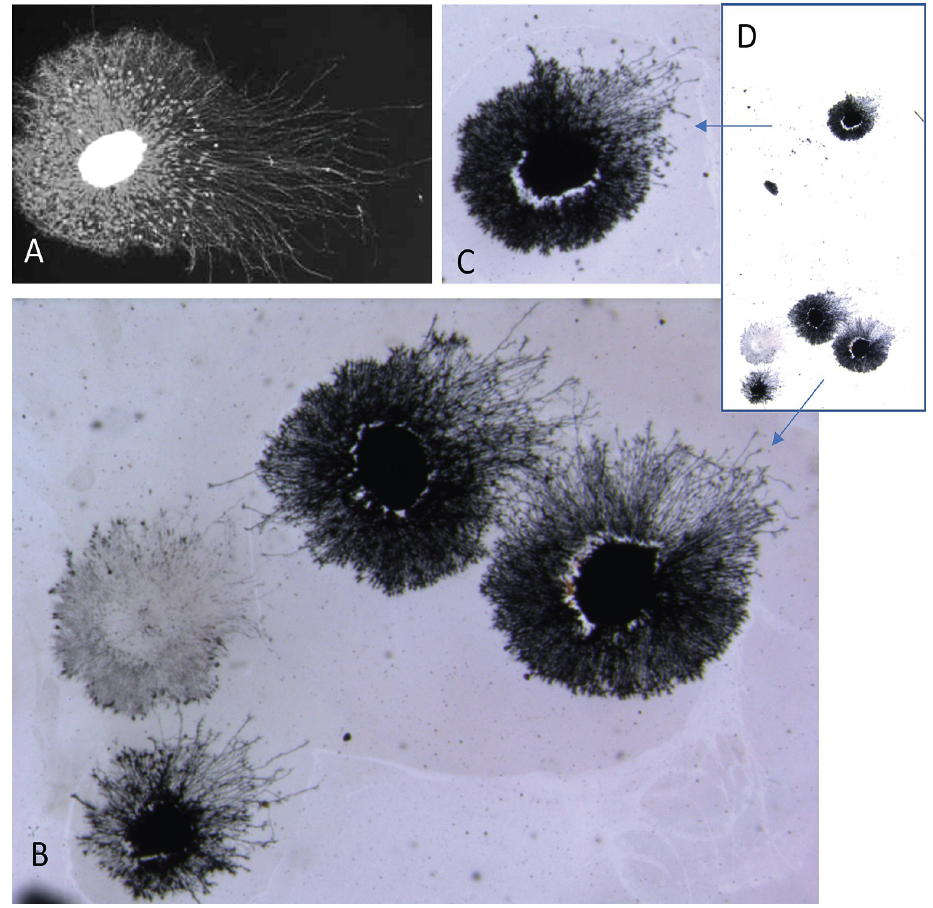
Fig 9. Sensory ganglia explants exhibit asymmetry and co-orientation. An example of a sensory ganglion explant stained with vital dye exhibiting asymmetric neurite growth [A]. A cluster of four silver-stained sensory explants show co-oriented asymmetry [B] along with a more distant explant in the same culture dish [C]. The inset [D] shows the distribution of the five explants in the dish. The upper left explant core in the cluster was lost during the staining procedure but the remnants of the neurite halo